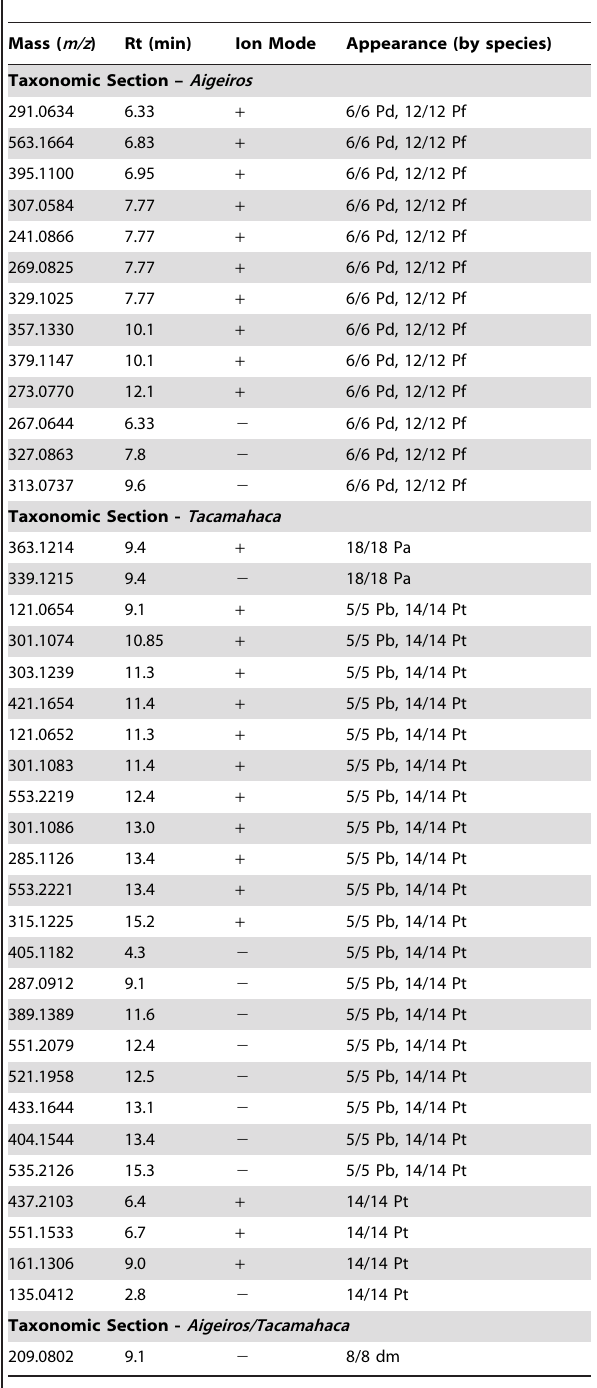
Table arranged by peak appearance in a given species group. The number of samples within a species group in which each peak appears is indicated in the last column. Retention time was rounded to the nearest 0.1 min. Pd = P. deltoides , Pf = P. fremontii , Pa = P. angustifolia , Pb = P. balsamifera , Pt = P. trichocarpa , dm = P. deltoides x maximowiczii . Mass accuracy was 2 ppm. Rt = retention